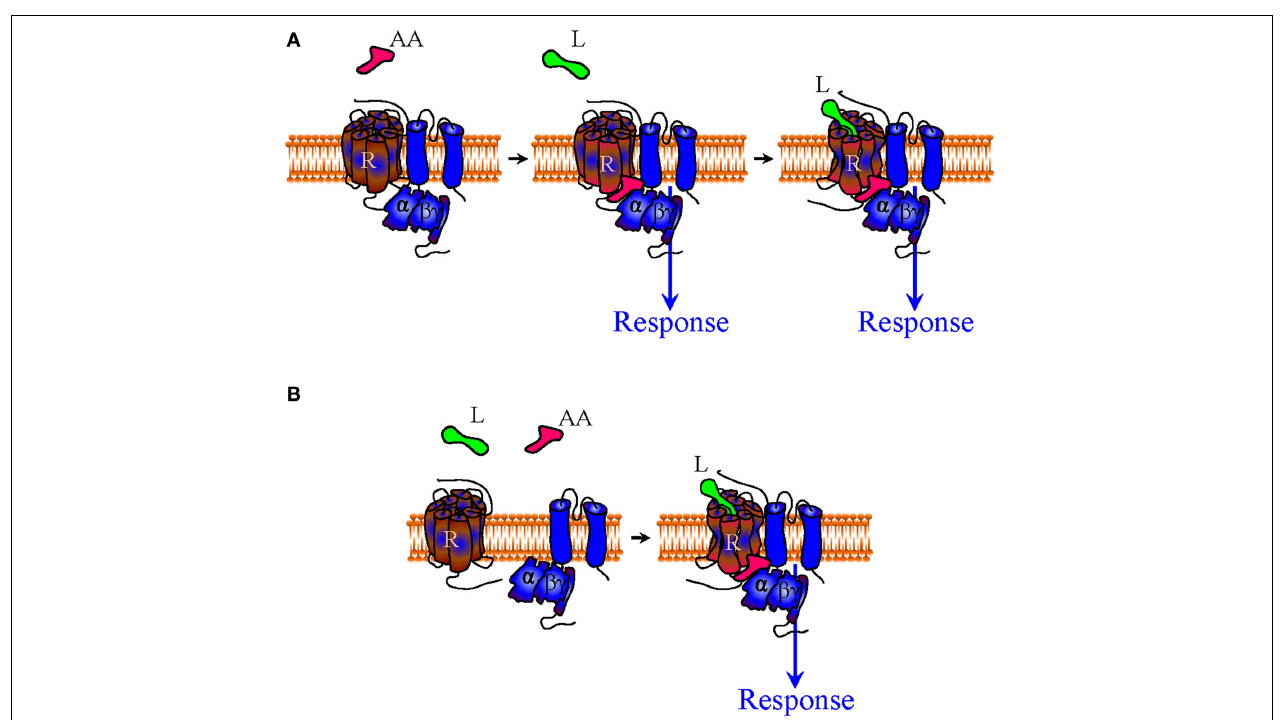
FIGURE 4 | Mechanisms of indirect bias involving allosteric agonists that specifically recognize a complex of desired composition. A complex-specific allosteric agonist (AA) may distinctively recognize an interface that is unique to the complex of interest. In the context of the